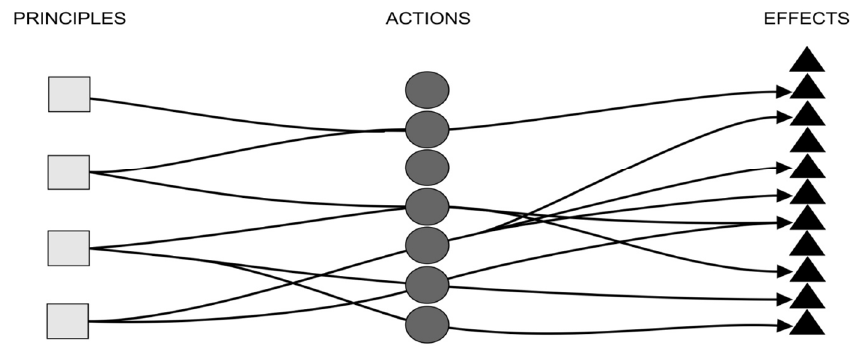
Figure 5. Principles of utilising the holistic model. Each principle can be implemented through different actions, with some of them producing similar effects. It is essential that designers be aware of which principles to implement, which actions to take, and, accordingly, which effects to expect. Particular goals may be considered to be more important than others or less so, depending on the adopted principle. There are always, however, goals that will not be implemented through the applied principle [6].